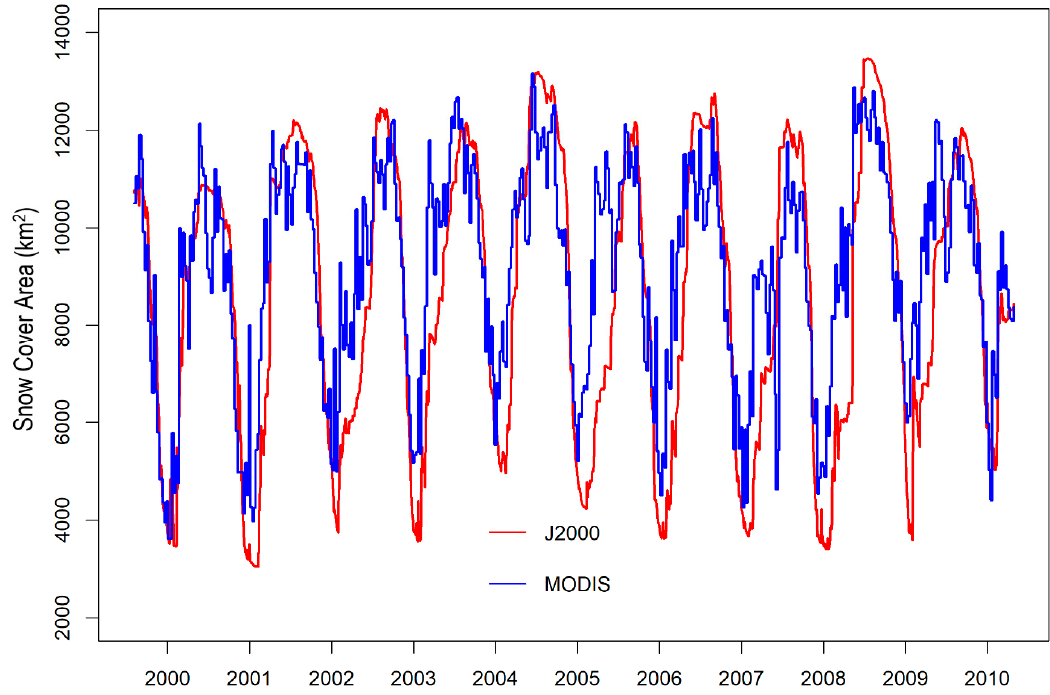
Figure 4. Daily snow cover area simulated by the J2000 model compared with MODIS 8-day interval snow cover data for the same period.